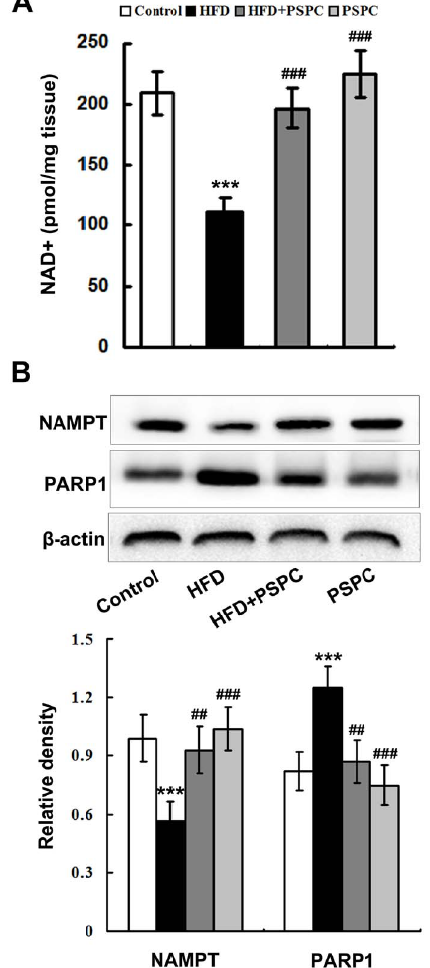
Figure 3. PSPC restores NAD + level in HFD-treated mouse livers. ( A ) Hepatic NAD + levels in all treated groups ( n = 5); ( B ) Immunoblotting and densitometry analysis of NAMPT and PARP1 in mouse livers ( n = 3). All of the values are expressed as the mean ± SD. *** p < 0.001 vs. the control group; ## p < 0.01, ### p < 0.001 vs. the HFD